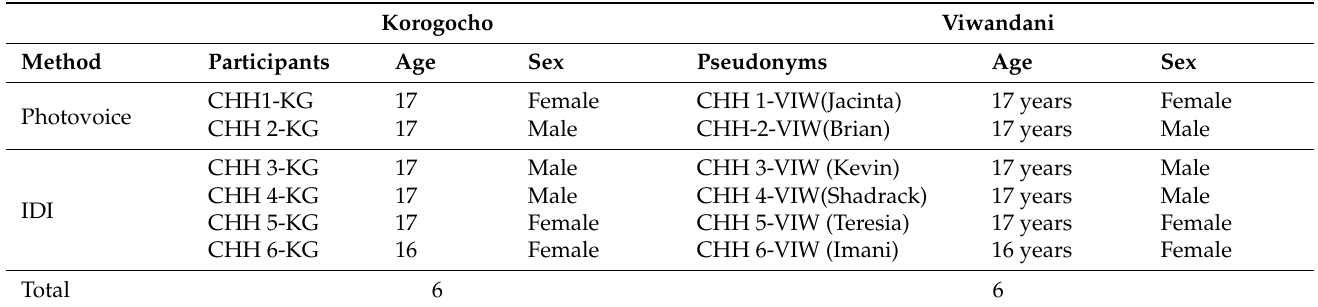
Table 1. Study participants (n =